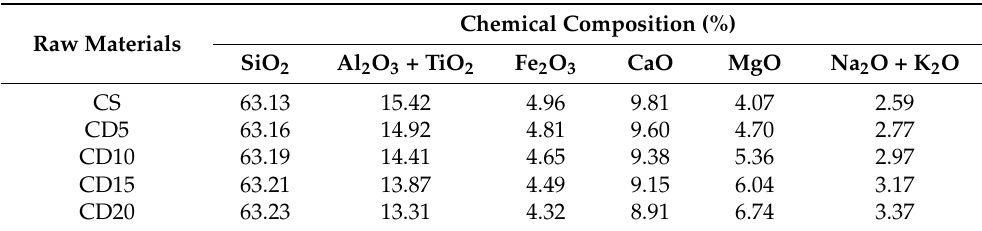
Figure 5. OCW particle size distribution. Table 3. Chemical compositions of the forming masses CS, CD5–CD20, calculated by eliminating losses on